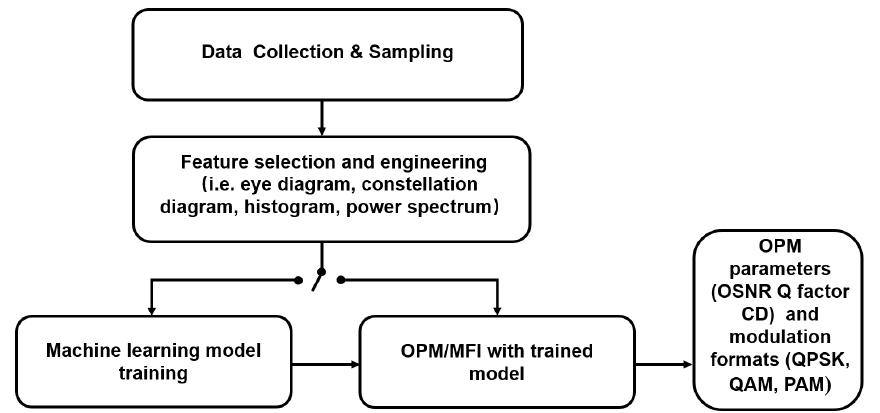
Figure 3. Procedure for OPM and MFI using machine